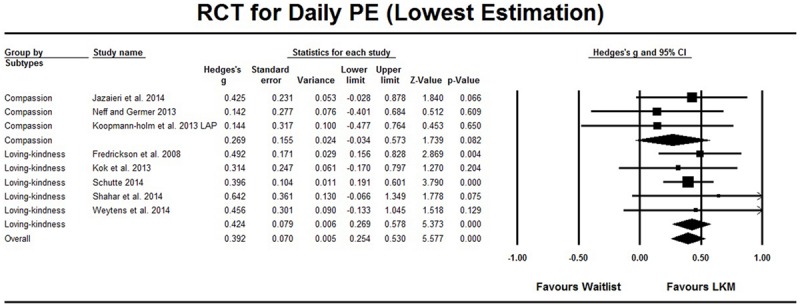
RCT studies on daily PE, comparison with waitlist control group. The lowest estimation was based on low arousal positive (LAP) emotion in Koopmann-Holm et al. (2013). Subgroup analysis compared LKM on loving-kindness and LKM on compassion.